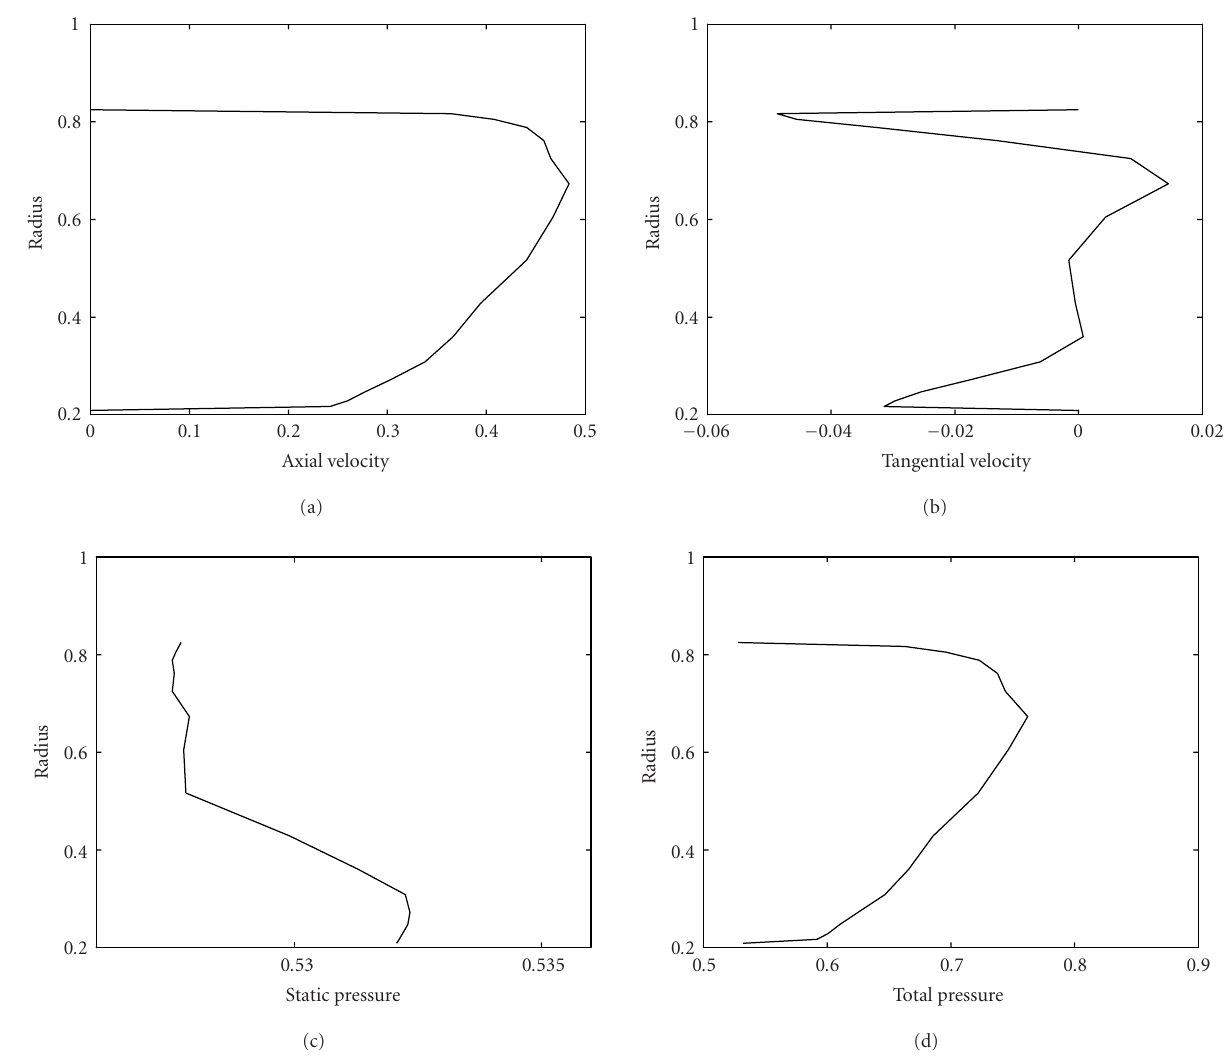
Figure 4: Nondimensional stator results, downstream